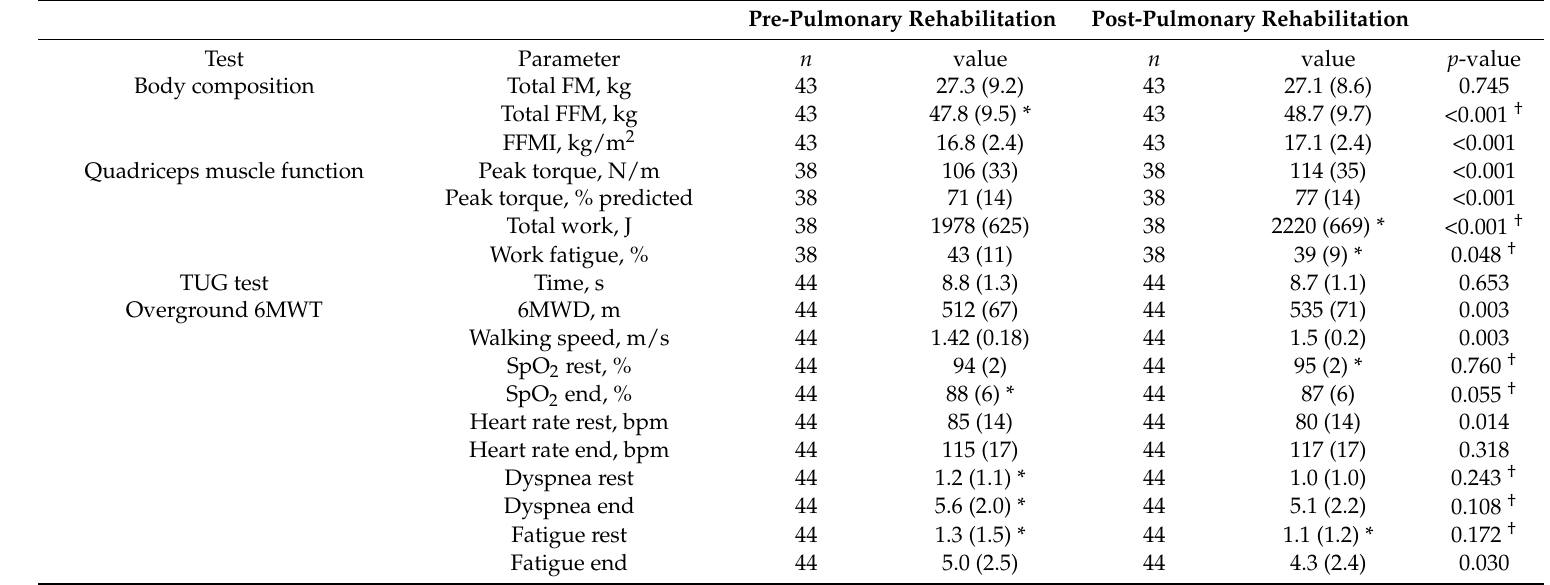
Table 2. Clinical outcomes before and after pulmonary